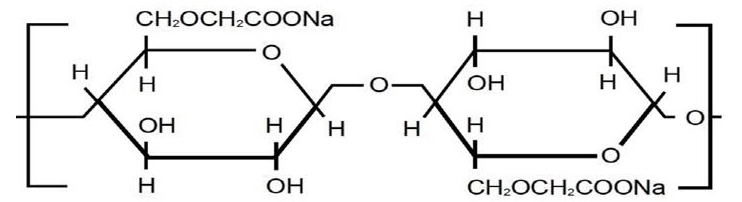
Figure 2. CMC structure.